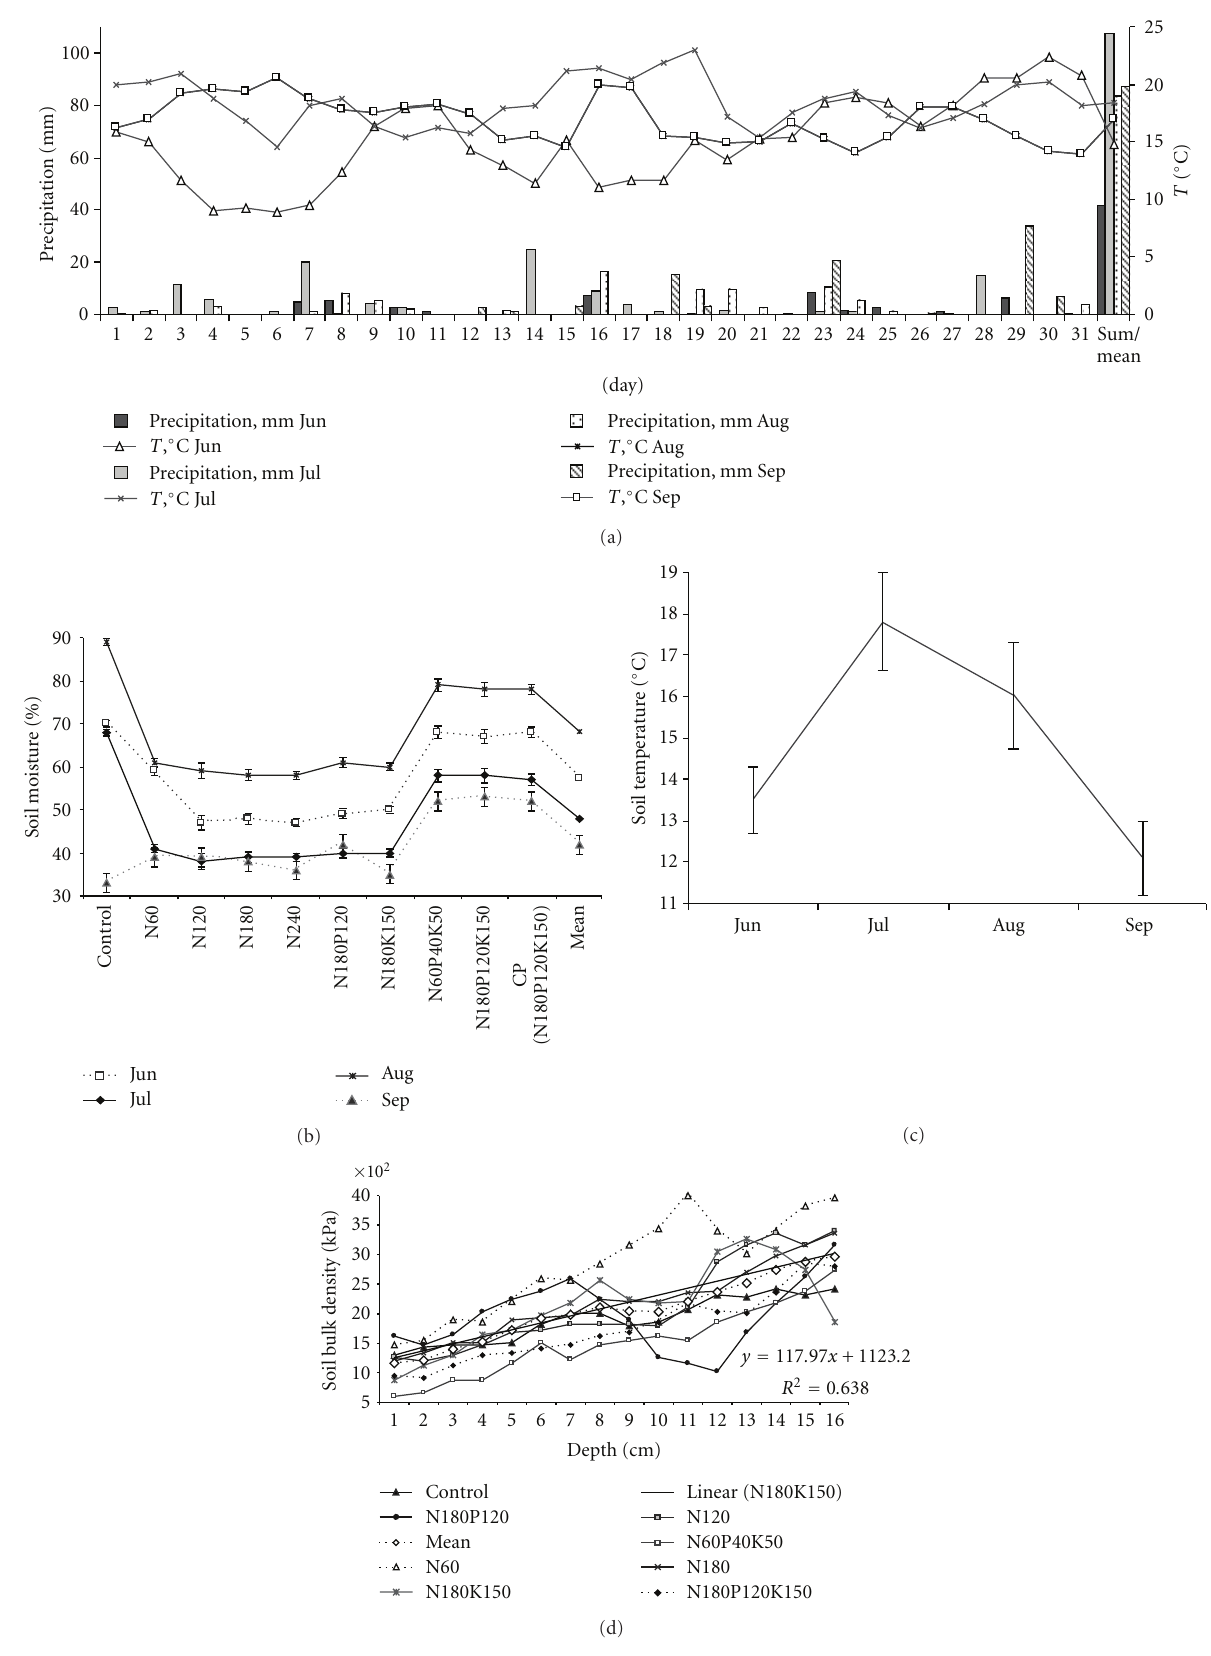
Figure 2: Meteorological conditions (a) and variation of soil characteristics during study period (JUN–SEP): (b) moisture, (c) temperature, and (d) soil bulk density at di ff erent depth (mean ±